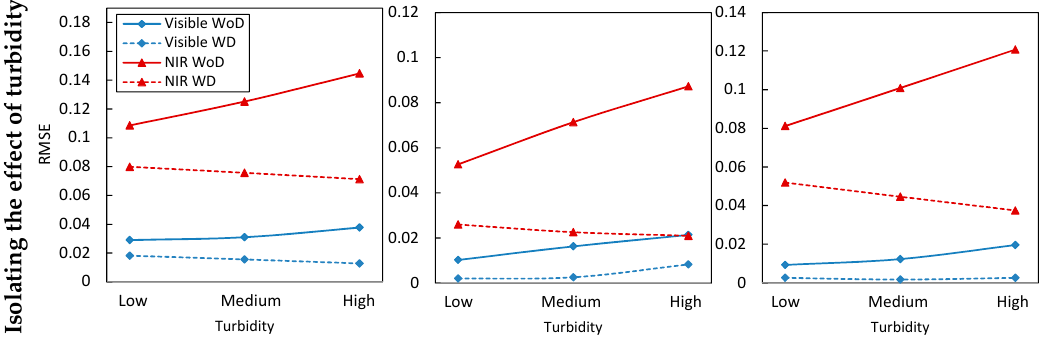
Figure 13. RMSEs (unitless) of reflectance retrievals using the database of R Sim _ WV 3 rs for three bottom types by isolating the effect of water depth (constant constituents: TSS = 4 g/m 3 , Chl-a = 3 mg/m 3 , a CDOM (440) = 0.14 m − 1 ) and the effect of constituents (constant 1 m deep water) with (WD) and without (WoD) accounting for deep-water reflectance R ∞ rs .